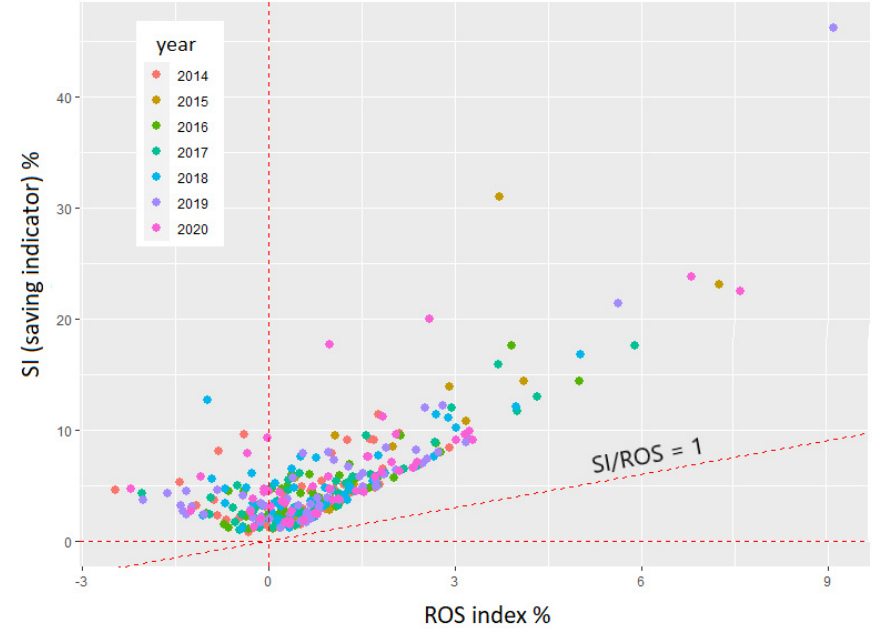
Figure 2. Powiats showing more than a 2.78-fold increase in ROS values. Thus, a slight upward trend can be noticed in the studied period. In turn, Figure 3 shows the spatial distribution of the same group of powiats, where the selected colors indicate the powiats showing growth (SI/ROS > 2.78) for a period of one to five years.